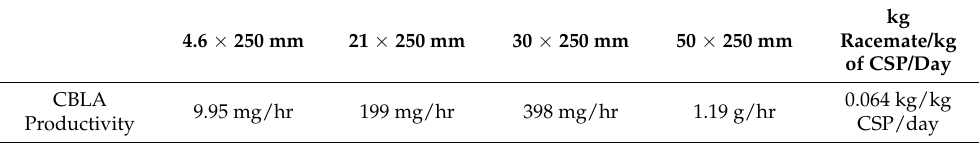
Table 10. Productivity of CBLA separation on various column